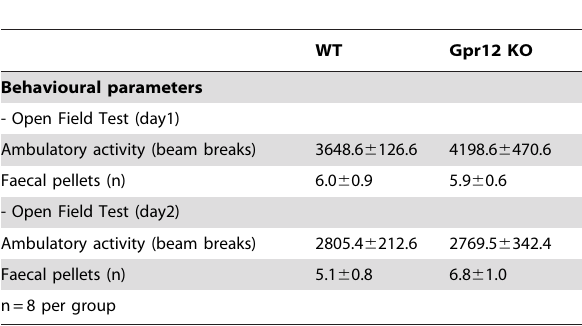
Table 3. Emotionality parameters of wild type (WT) and Gpr12 deficient (Gpr12 KO) mutant mice – Swedish